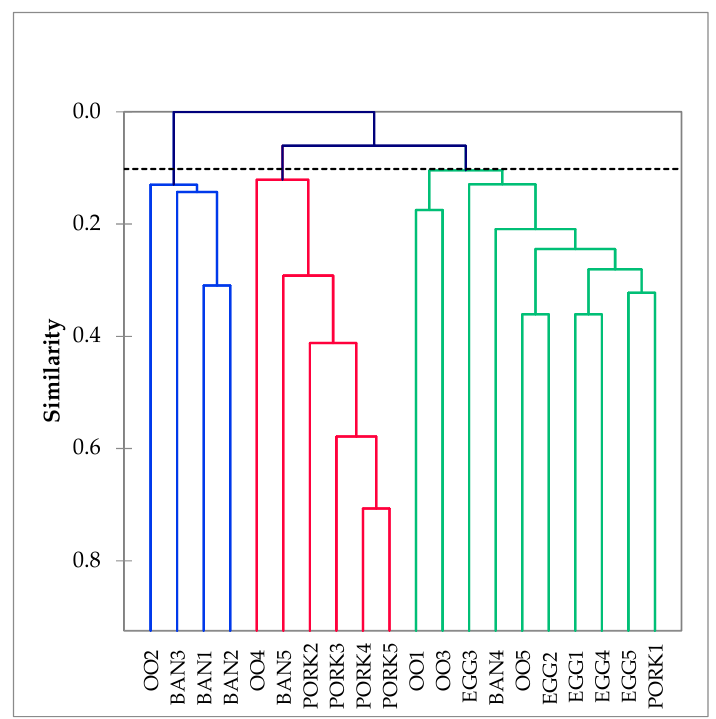
Figure 3. Dendrogram of the agglomerative hierarchical cluster analysis on the scores for the cultural and behavioral driver factors provided by the banana (BAN), egg (EGG), olive oil (OO) and pork (PORK) supply chain actors. Actors are indicated by their supply chain code followed by a number (e.g., BAN1).